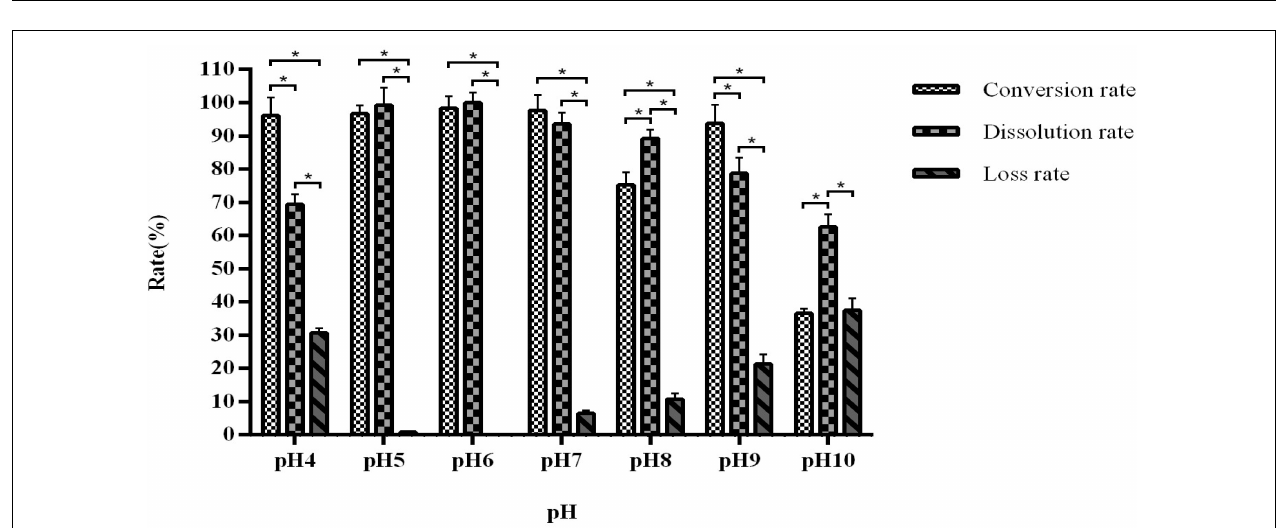
FIGURE 5 | The influence of medium volume on fermentation efficiency. *Indicates significance at the 0.01 level.